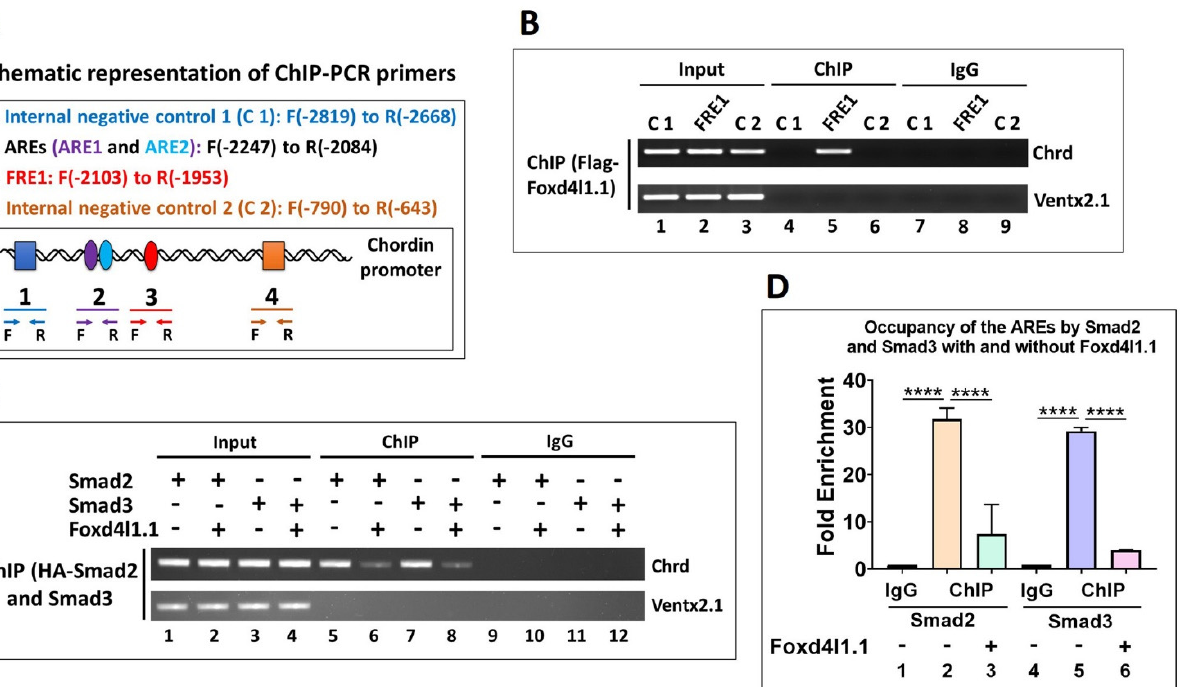
Figure 5. Foxd4l1.1 is bound to FRE1 and blocks Smad2/3 binding to AREs (ARE1 and ARE2). For ChIP-PCR, Flag- Foxd4l1.1 with or without HA-Smad2 and HA-Smad3 mRNA were injected at the one-cell stage, then harvested at stage 11: ( A ) ChIP-PCR primer design and C 1, ARE1, ARE2, FRE1, and C 2 locations within the chrd promoter are shown with F as location of the forward primer and R as location of the reverse primer; ( B ) chromatin immunoprecipitation assay was performed to examine the interaction of Flag-Foxd4l1.1 with FRE1, the two internal negative controls (C 1 and C 2), and one external negative control (Ventx2.1); ( C ) chromatin immunoprecipitation assay was performed to examine the occupancy of either Smad2 or Smad3 with or without Foxd4l1.1. Ventx2.1 served as external negative control; ( D ), ChIP-qPCR was performed to examine the occupancy of HA- Smad2 and HA- Smad3 to AREs with or without Flag- Foxd4l1.1 (fold enrichment method used to normalize the ChIP-qPCR reads). **** p ≤